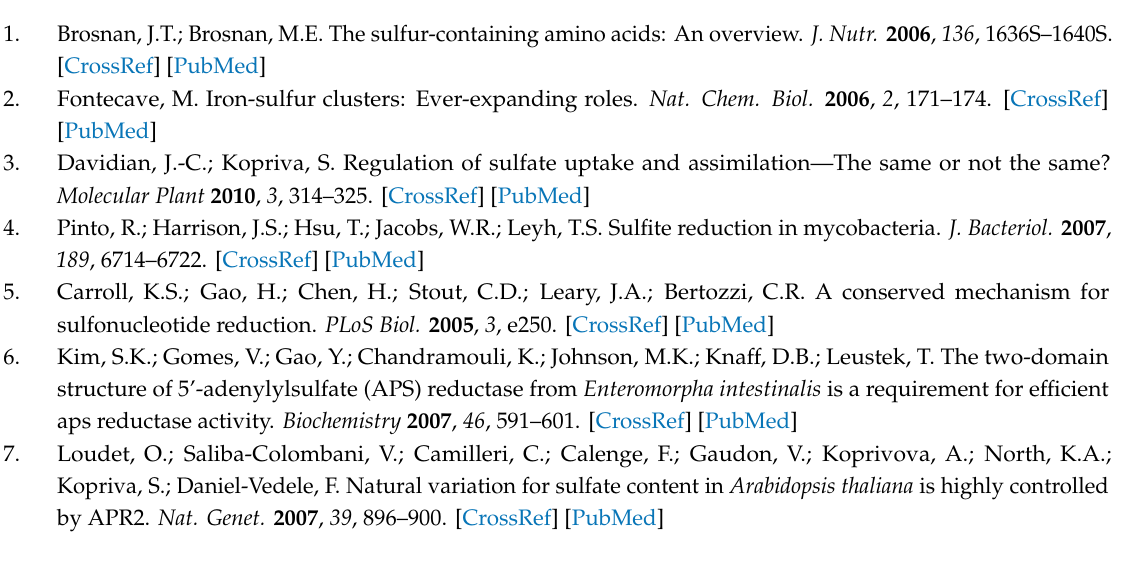
Figure S1: Ramachandran plot for crystal structure of AtAPR1 redox domain. Table S1: DALI comparisons using the structure of AtAPR1 redox domain protein that is closest to the mean of the ensemble PDB Z-score sequence identity protein. Table S2: RMSD calculation of four helices between AtAPR1 redox domain protein and the structural